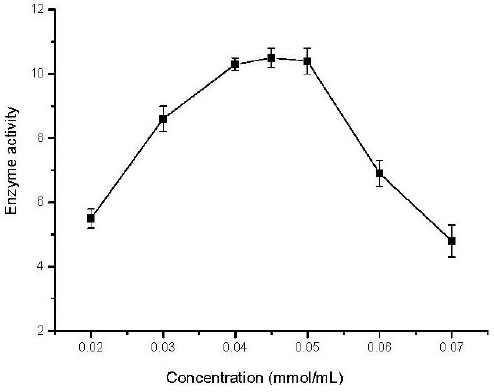
Figure 3. Effect of substrate concentration on the activity (μmol/g·h) of free and immobilized TVL. Reaction conditions: trans-resveratrol: 0.02–0.07 mmol, n -butanol 40 mL, Na HPO –sodium citrate buffer 10 mL; (pH 5.0), immobilized TVL laccase 2 4 (enzyme content: 5 mg), reaction temperature: 45 °C